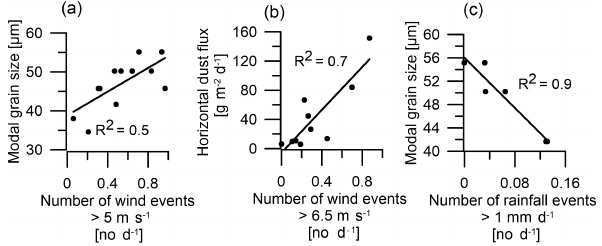
Figure 7. Correlation between the observed local surface wind speed at site Iwik and the measured (a) modal grain size and (b) flux. (c) Correlation between the observed local precipitation at site Iwik (TRMM data) and the modal grain size of the summer